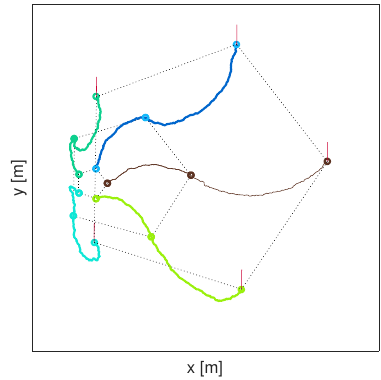
Figure 1. An illustration of a path of a coordinated group of N = 5 searching robots at three consecutive time instants, with the scale of the formation increasing. The small circles in the figure represent robot locations r i ; the vertical lines indicate the current headings φ i k